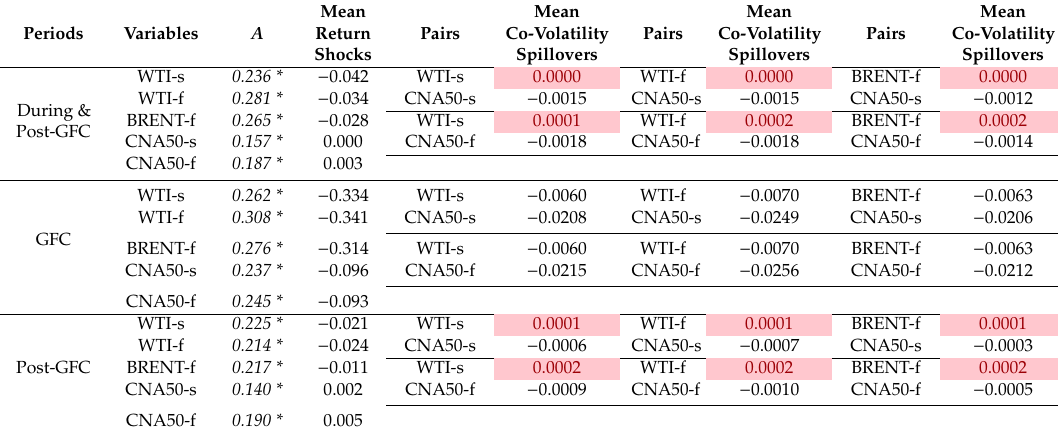
Table 12. Matrix A in Diagonal BEKK, mean return shocks, and mean co-volatility spillovers for the UK and US crude oil markets and Chinese financial markets, three periods (5 ×